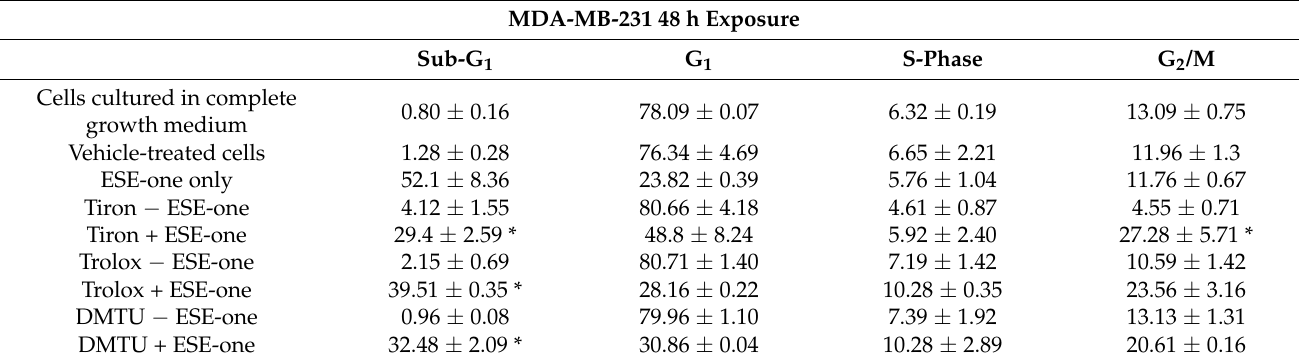
Table 4. Percentage of MDA-MB-231 cells occupying each cell cycle phase as determined by means of flow cytometry using propidium iodide after 48 h exposure. An asterisk (*) indicates p -value ( p < 0.05) compared to ESE-one treated